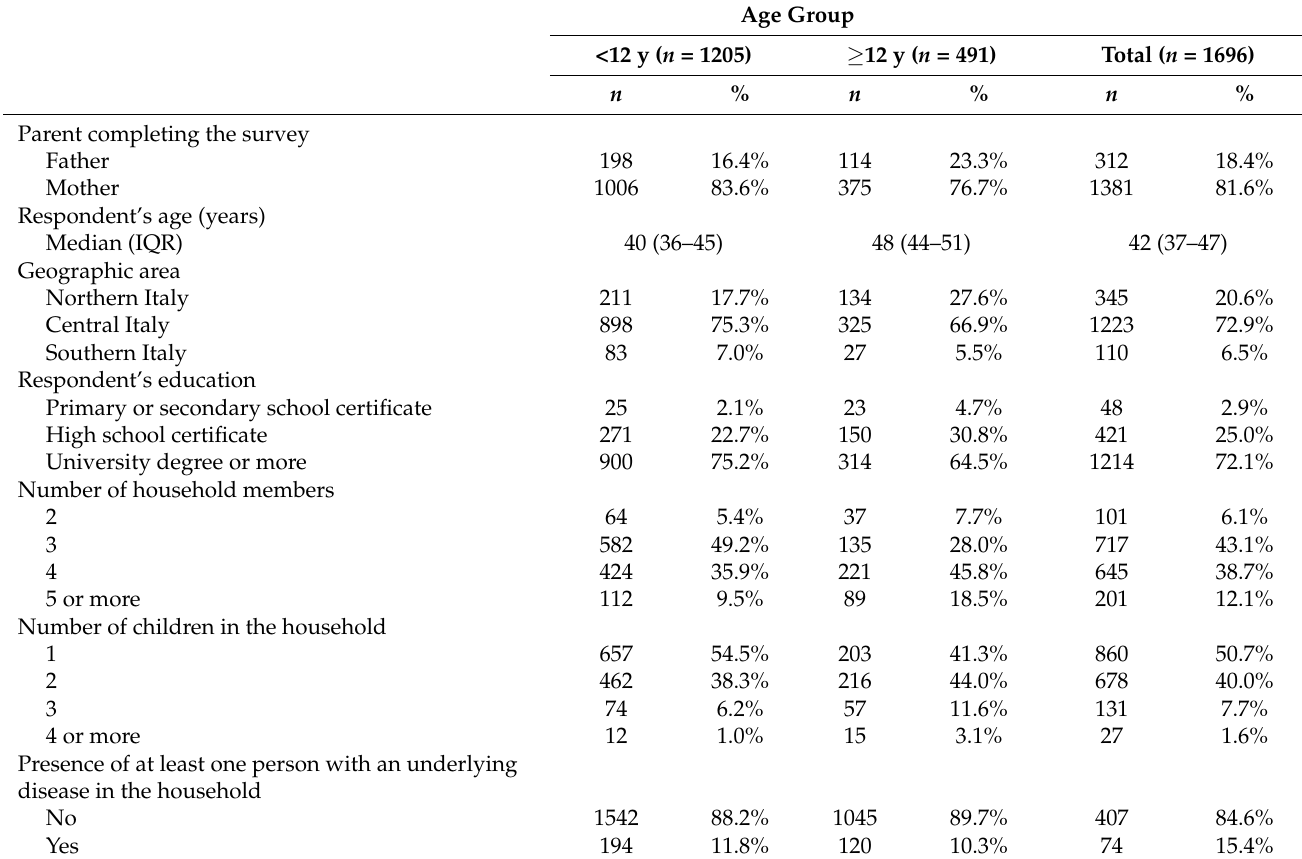
Table 1. Characteristics of the study